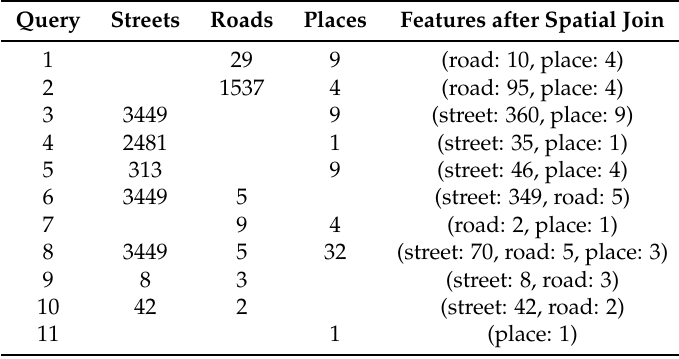
Table 3. The features involved in each query, where the columns Streets , Roads , Places are the number of instances retrieved from WFS servers for each type of feature.